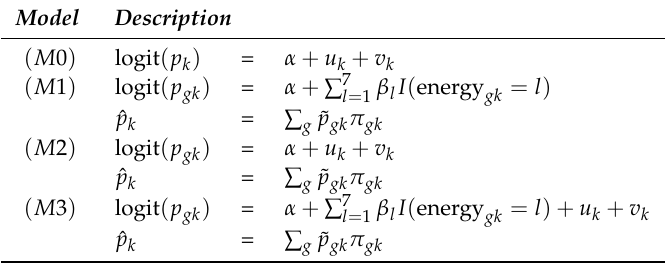
Table 2. Overview simulation scenarios for Simulation 2. The first column is used to identify the matching simulation settings, specified in the second